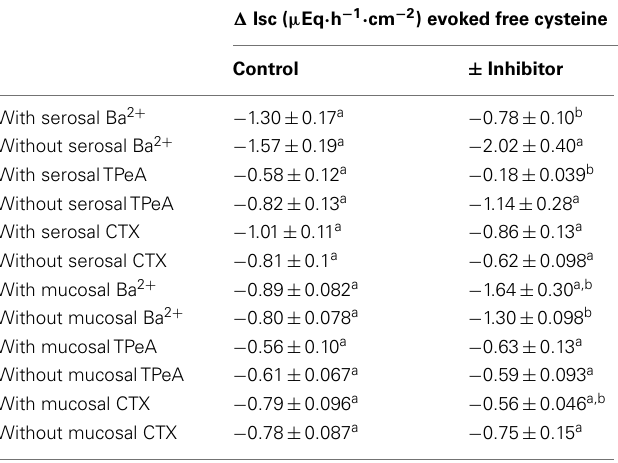
Table 4 | Effect of free cysteine after blockade of K + channels.